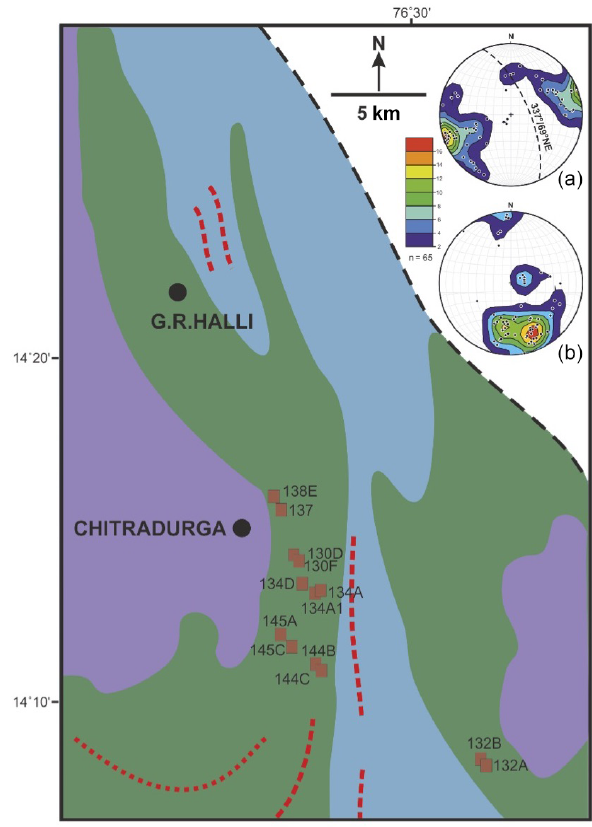
Figure 5. Map showing the location points (marked with brown boxes) from which oriented metabasalt samples for AMS analy- sis have been collected. (a) Lower hemisphere equal area projec- tion of poles ( K 3 ) to the magnetic foliation ( K 1 K 2 ) plane. Mean orientation of the K 1 K 2 plane (dashed great circle) = 337/69 ◦ NE. (b) Lower hemisphere equal area projection showing the distribu- tion of magnetic lineation ( K 1 ). Color scheme of the legend indi- cates variation in the contour density. n : number of